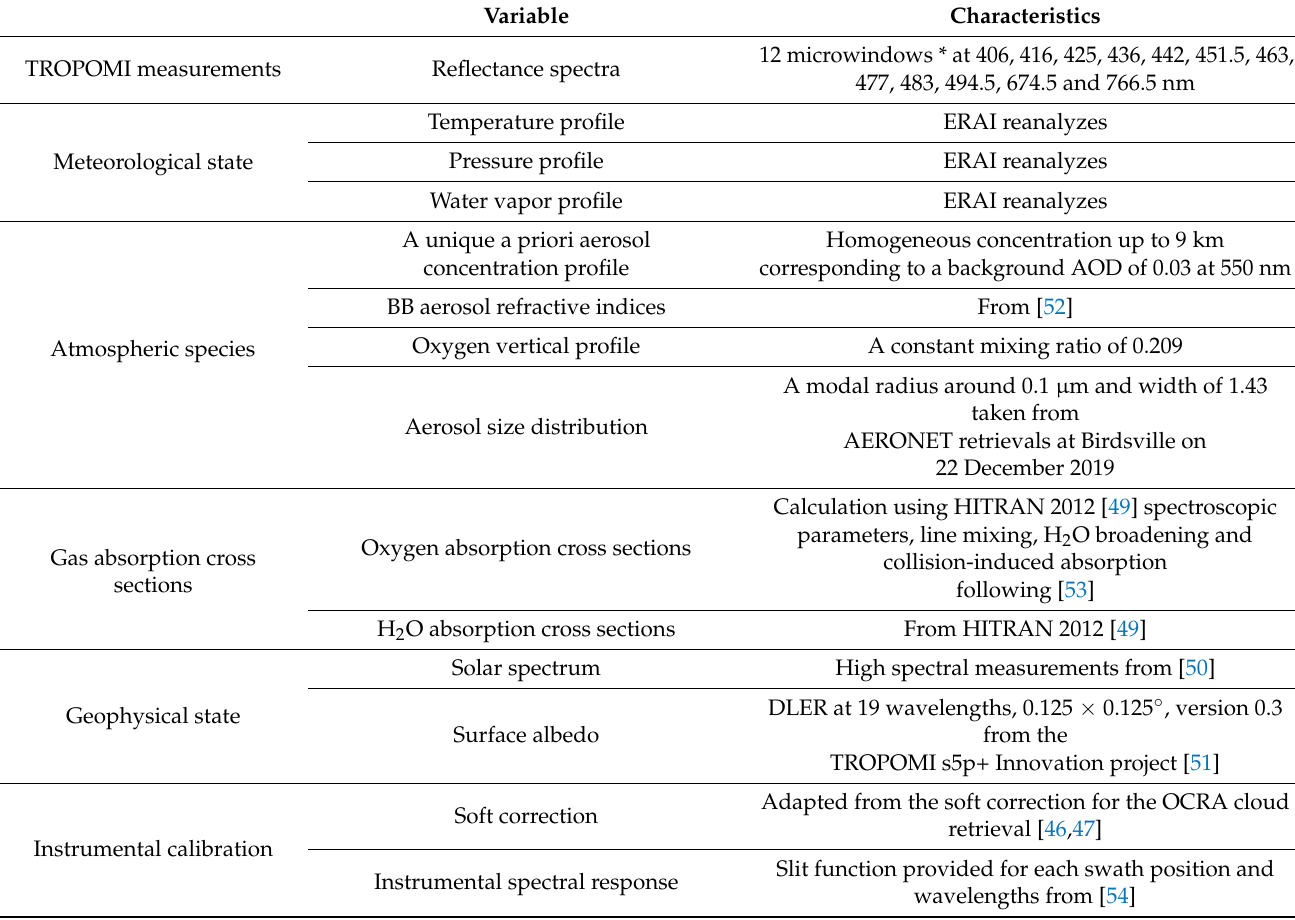
Table 1. AEROS5P inputs and their corresponding